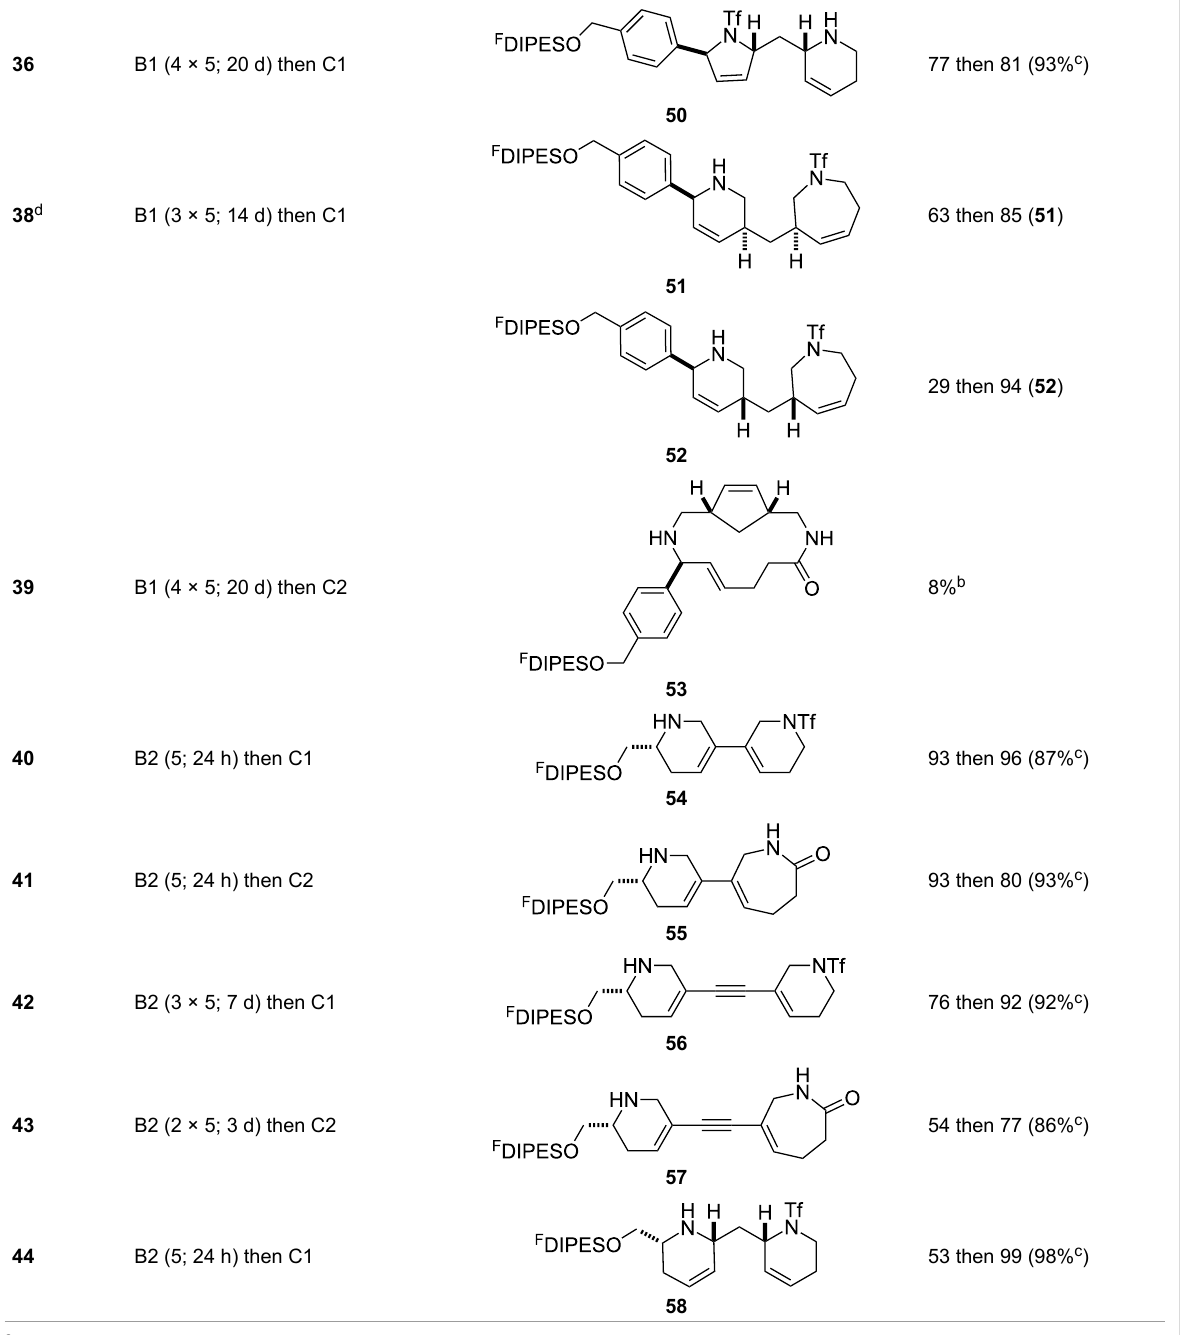
Table 3: Application of cascade metathesis reactions in the synthesis of diverse scaffolds and subsequent desulfonylation.